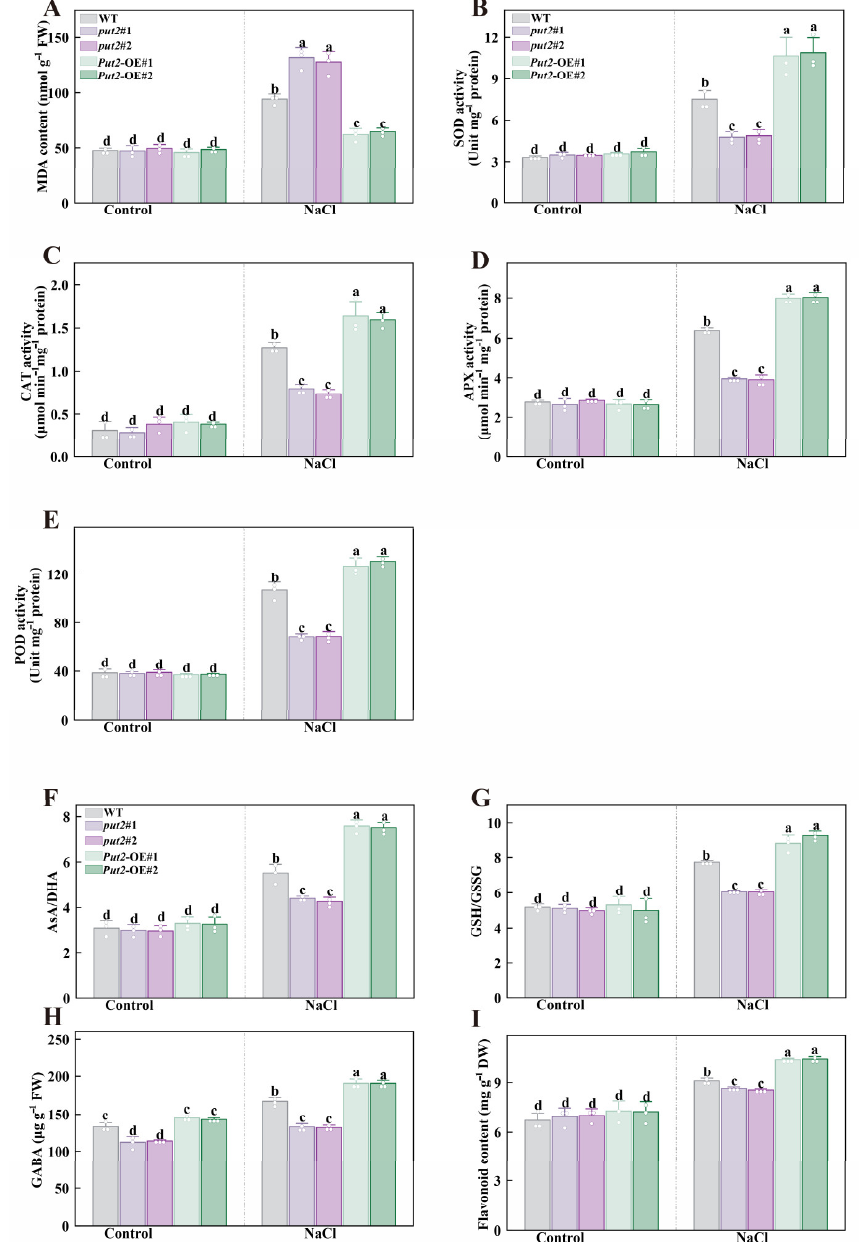
Figure 7. Put2 enhances salt tolerance via positively regulating ROS-scavenging enzyme activity and nonenzymatic antioxidant process. The MDA content ( A ), SOD ( B ), CAT ( C ), APX ( D ), and POD ( E ) activity in WT, put2 mutants, or Put2 OE lines with or without salt stress for 7 days. ( F ) The ratio of ascorbic acid (AsA) to dehydroascorbate (DHA), ( G ) the ratio of glutathione (GSH) and glutathione disulfide (GSSG), ( H ) the gamma-aminobutyric acid (GABA), and ( I ) the total flavonoids in WT, put2 mutants, or Put2 OE lines with or without salt stress for 7 days. Data are presented as mean values ± SD; n = 3. Different letters indicate significant differences between treatments ( p < 0.05, Duncan’s multiple range test). At least three independent experiments were